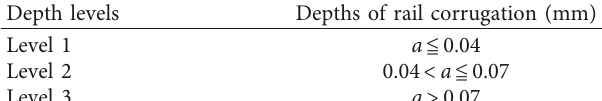
Table 5: Definition of depth levels of rail